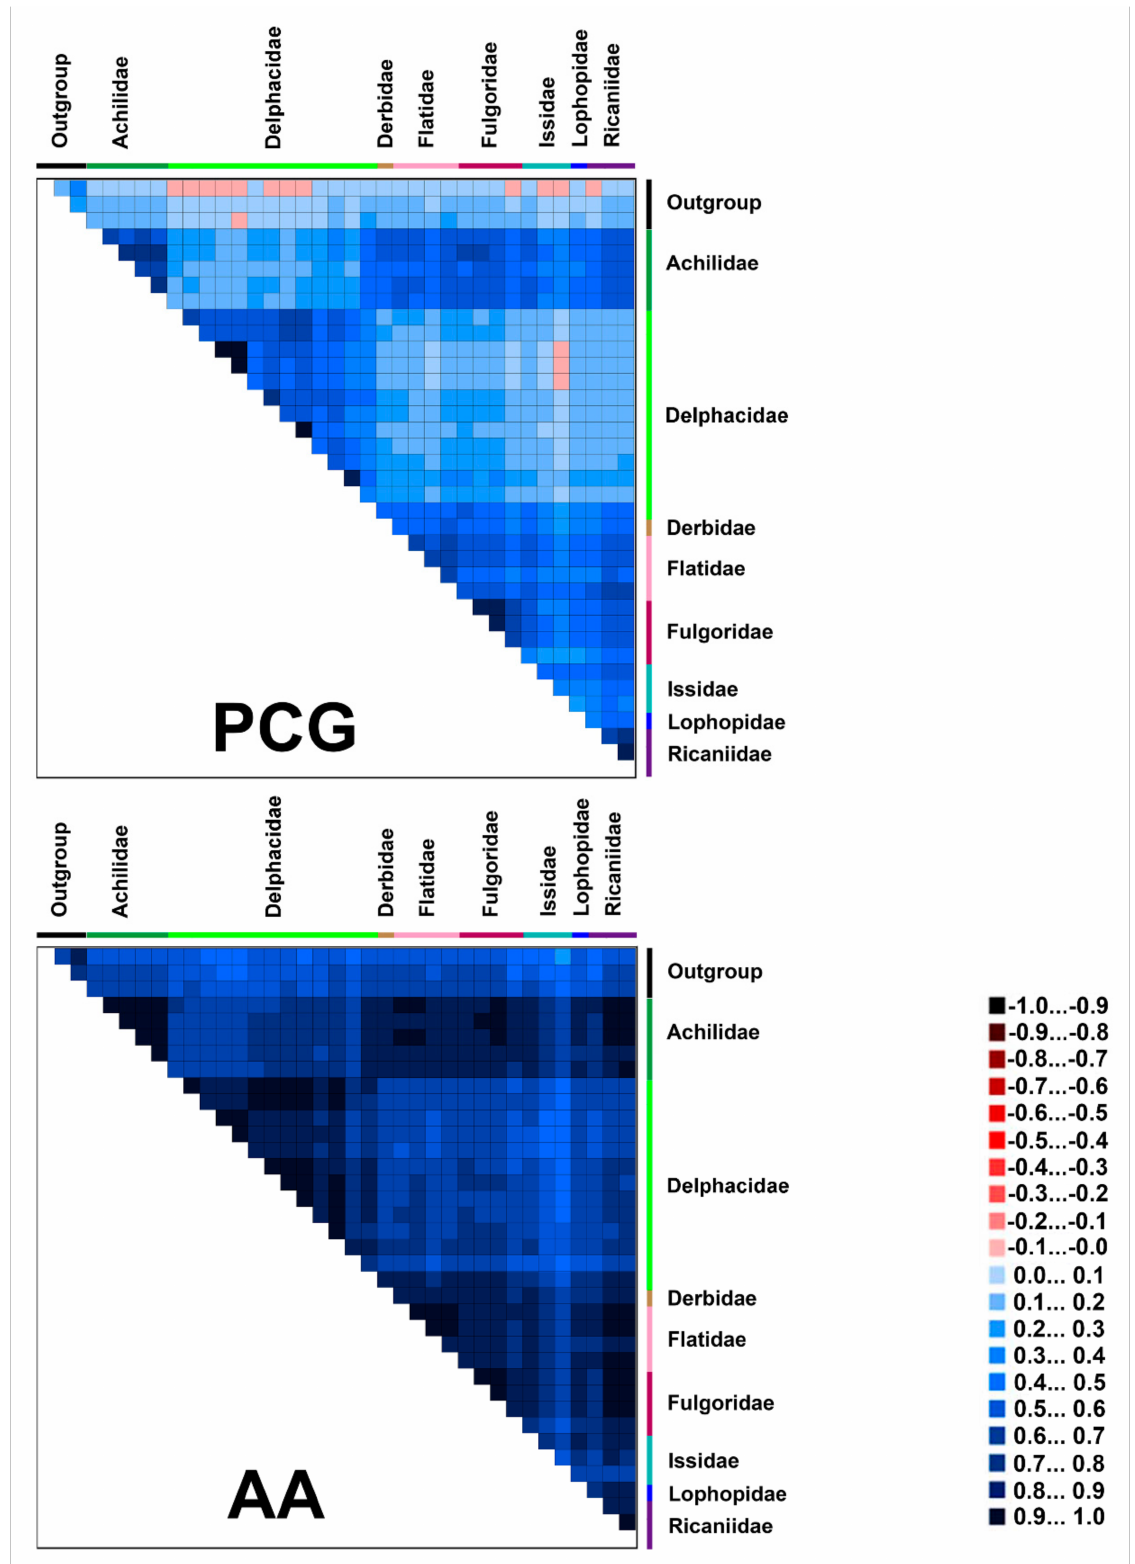
Figure 4. Heterogeneous sequence divergence within datasets PCG and AA of planthopper mitogenomes. The mean similarity score between sequences is represented by a colored square. AliGROOVE scores ranging from − 1 (indicating great difference in rates from the remainder of the dataset; red coloring shows the significant heterogeneity) to +1 (indicating rates match in all other